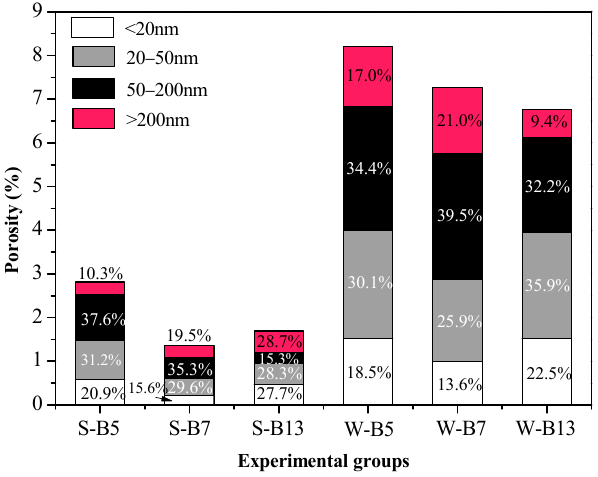
Figure 8. Pore size distribution of AA-FASM under seal- and water-saturation-curing conditions.